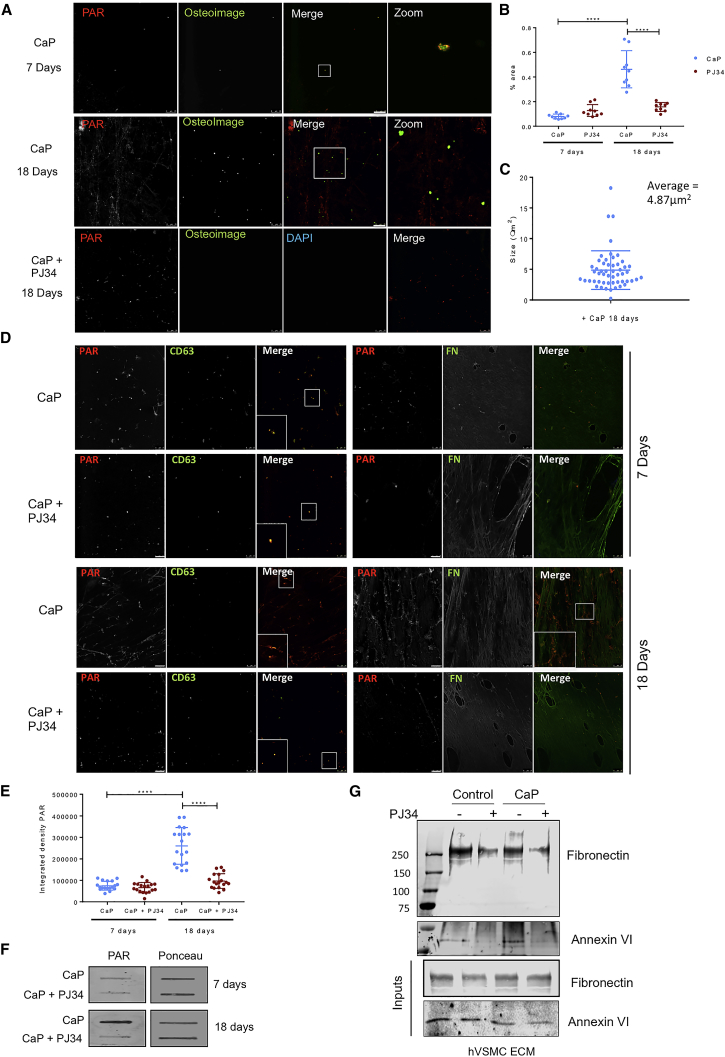
PAR Is Released into the ECM via Cell Lysis and EVs and Binds ECM Proteins(A) Immunofluorescence showing deposition of PAR and co-localization with OsteoImage in the ECM from hVSMCs treated in calcifying conditions for 7 and 18 days in the presence or absence of PJ34. Scale bar, 25 μm. See also Figures S3A–S3C.(B) Quantification of mineralization in the ECM of hVSMCs induced to calcify in the presence or absence of PJ34 (n = 3). Mean ± SD, 2-way ANOVA, ∗∗∗∗p < 0.0001. See also Figures S3D and S3E.(C) Quantification of calcified particle size (OsteoImage spheres) at day 18 after induction of calcification (n = 3). Mean ± SD.(D) Immunofluorescence showing deposition of PAR and co-localization with CD63 and fibronectin in the ECM from hVSMCs treated in calcifying conditions for 7 and 18 days in the presence or absence of PJ34.(E) Quantification of PAR deposition in the ECM in calcifying conditions in the presence and absence of PJ34 (n = 3). Mean ± SD, 2-way ANOVA, ∗∗∗∗p < 0.0001.(F) Protein slot blot showing increased PAR production in calcifying hVSMCs (CaP) and its inhibition by PJ34 (representative of n = 2 experiments).(G) Boronate bead binding assay and western blot for fibronectin and annexin 6 showing reduced binding to PAR in the ECM of hVSMCs treated with PJ34 (representative of n = 2 experiments). Input shows equal loading onto beads.